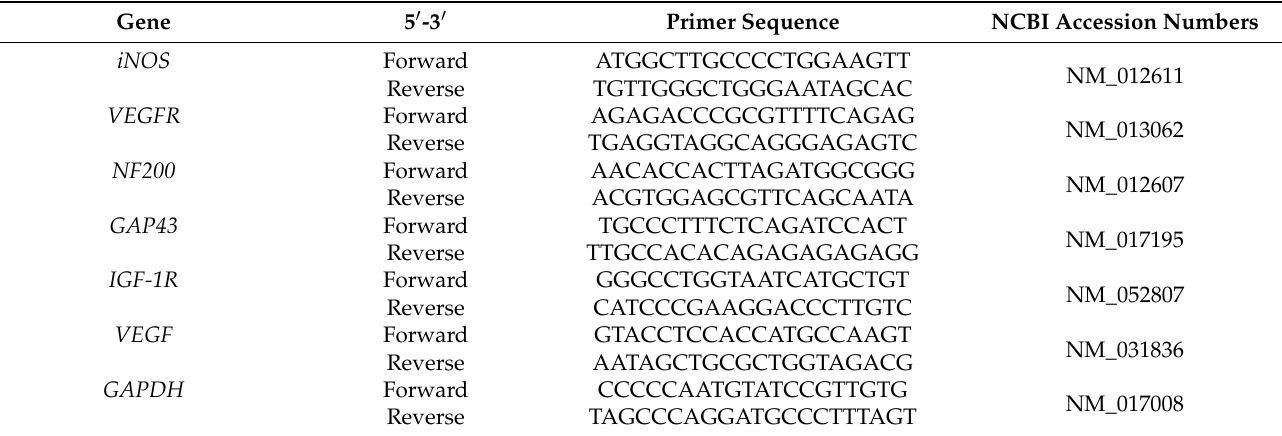
Table 1. Primer sequences used for real-time PCR